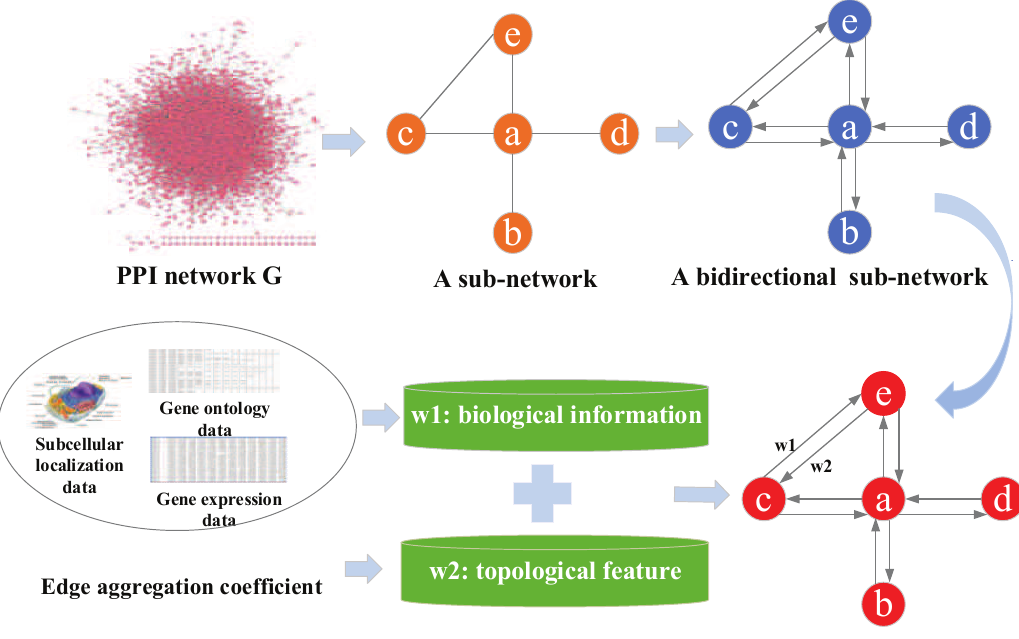
Figure 2. An illustration of weighted PPI network